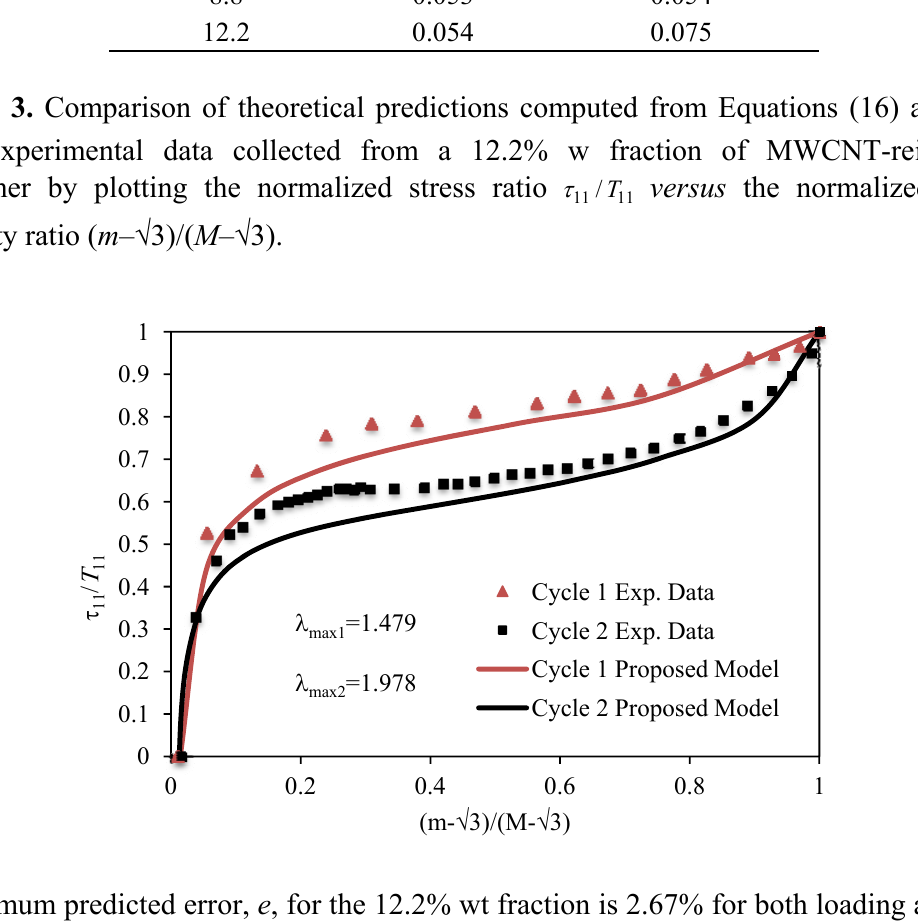
/ T  versus the normalized strain 11 11